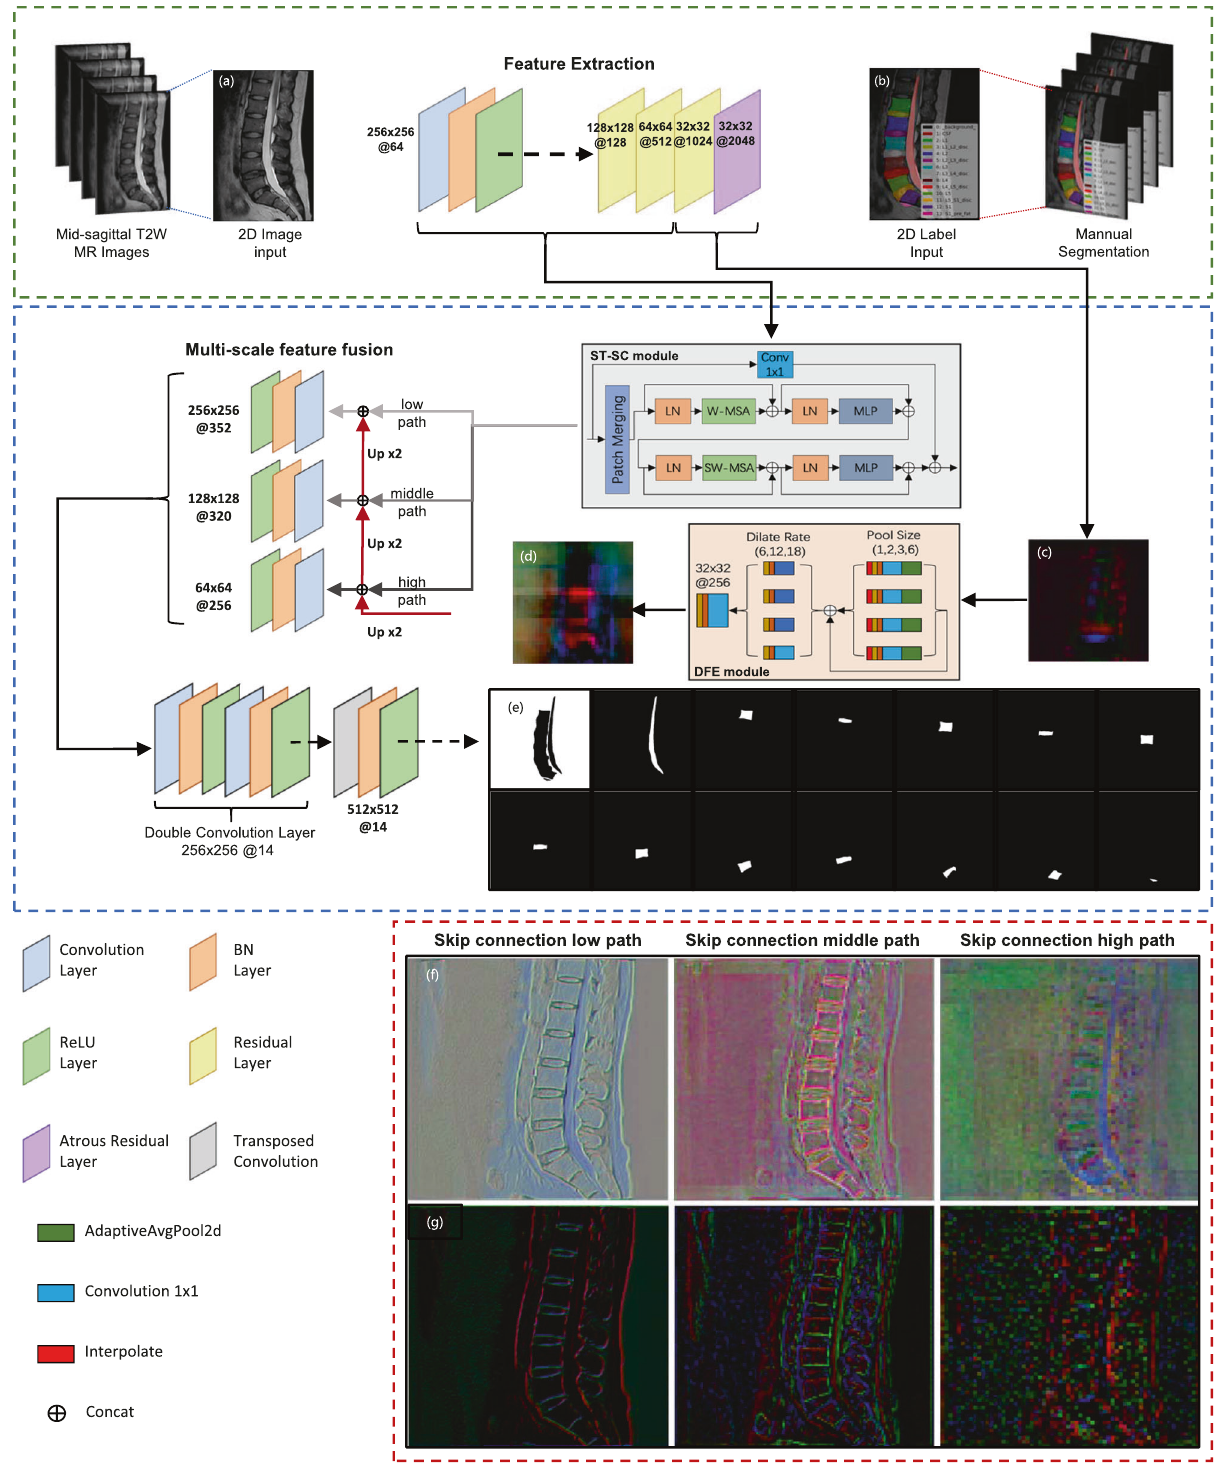
Fig. 4 The proposed BianqueNet consisted of three innovative modules. a Input MRI, ( b ) annotations, feature map before ( c ) and after ( d ) DFE module, and ( e ) each image-channel output by the model corresponds to a segmentation area. Feature map of different skip-connection path with ( f ) and without ( g ) ST-SC semantic information but rich spatial information. Then a 3 * 3 double-convolutional different resolutions obtained by downsampling to the Swin Transformer-skip layer is used for the fused feature map to improve the feature, and fi nally a double connection module (see “ Swin Transformer – skip connection ” section for details), upsampling operation is performed to obtain a dense prediction image. and then fuse the upsampled feature maps of the same resolution to obtain feature maps of different scales. According to Feature Pyramid Network 36 , multi-scale feature fusion module (MFF) is used to combine the feature maps with strong low- Swin transformer – skip connection module . Applications with transformer-based resolution semantic information and feature maps with weak high-resolution vision backbones such as Vision Transformer (ViT) achieved innovative